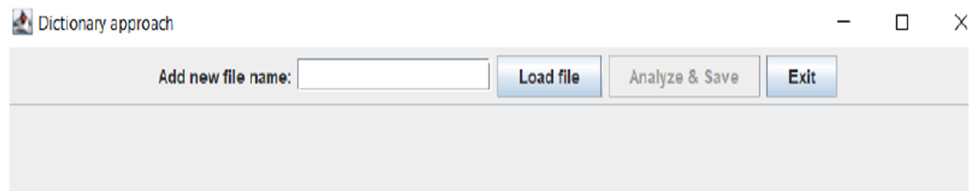
Figure 7. Window for a text data loading and an analysis starting.